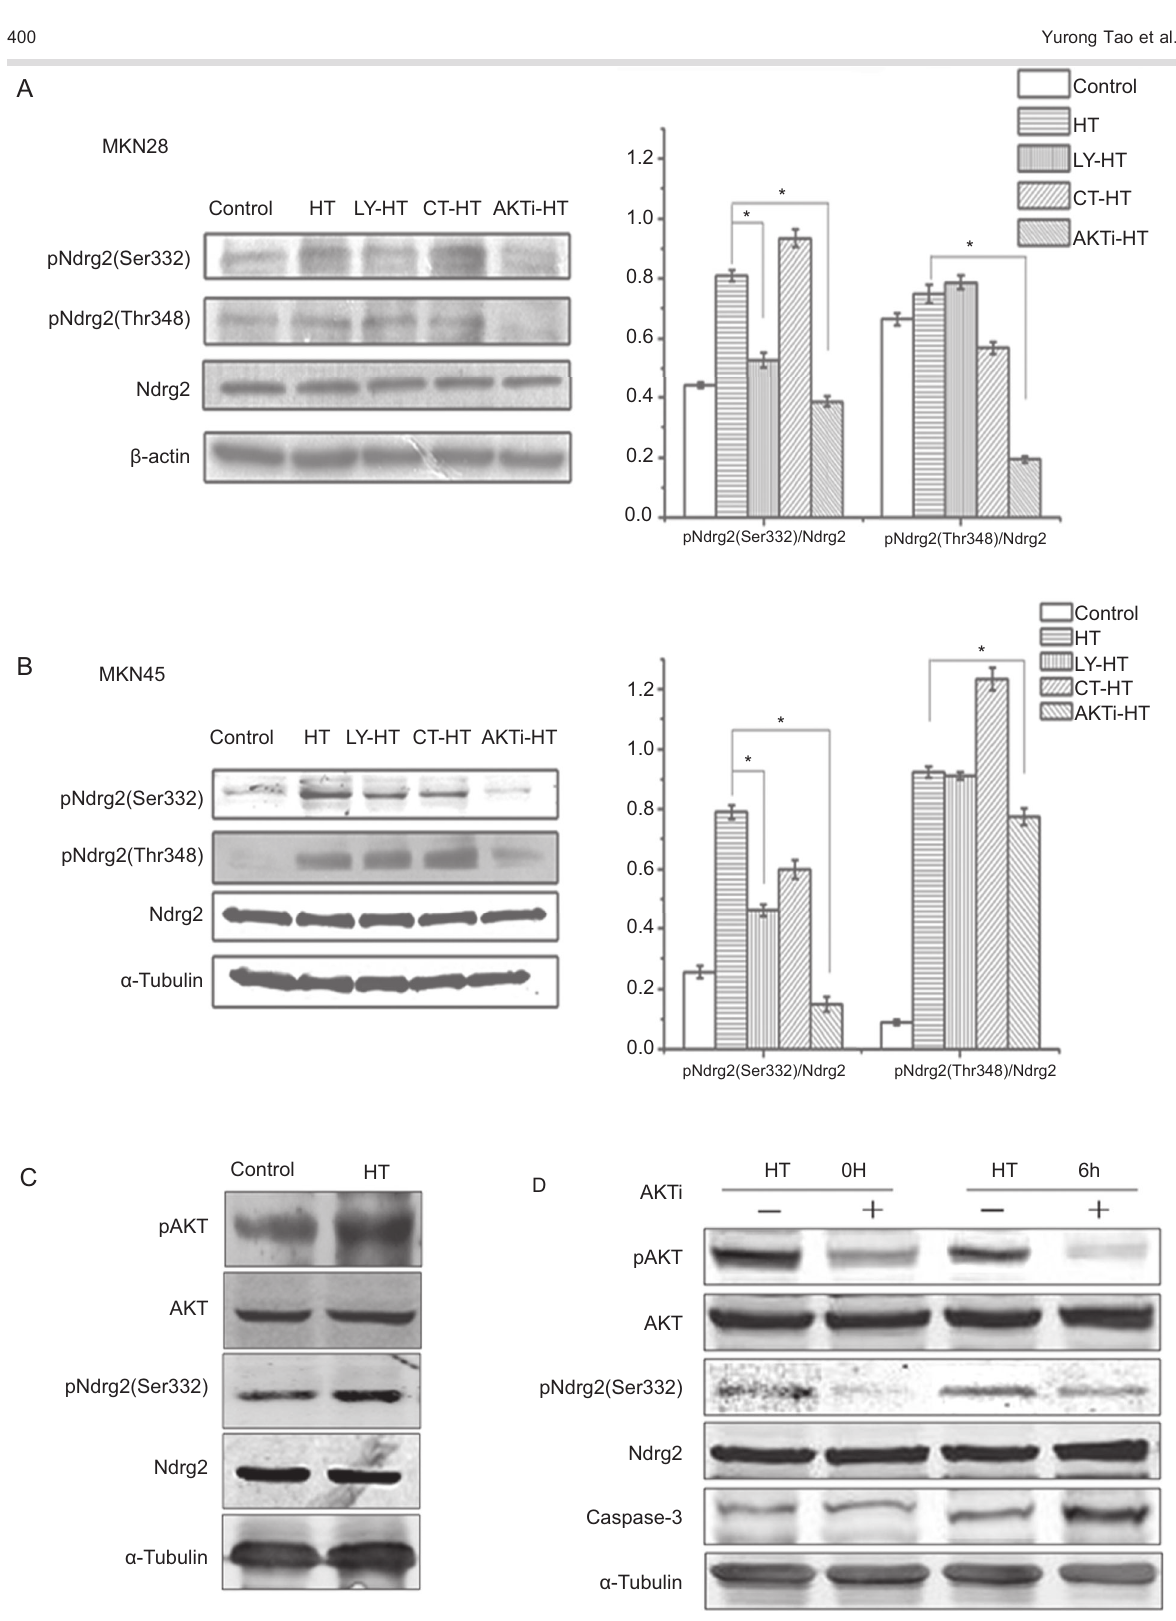
Figure 4. See legend on next